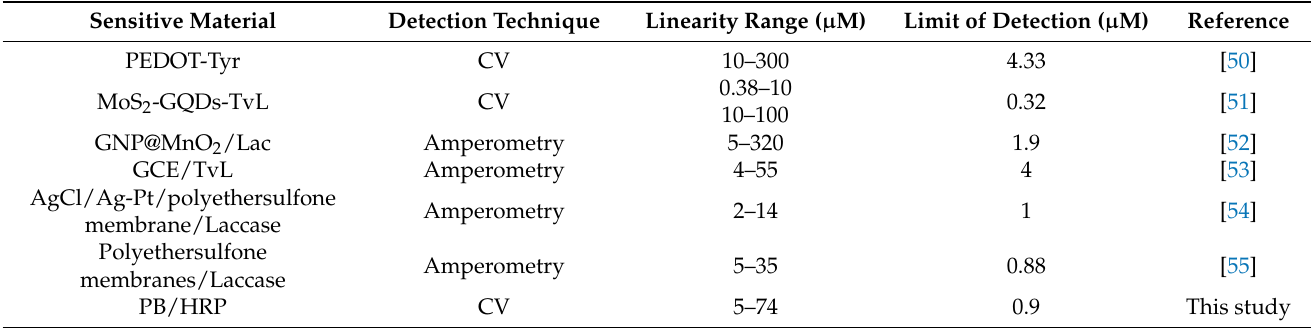
Figure 6. ( a ) Overlapping cyclic voltammograms of SPCE/PB/HRP biosensor, immersed in different solutions with variable concentrations of caffeic acid (electrolyte support was 10 − 2 M PBS pH 7–10 − 2 M hydrogen peroxide solution); ( b ) plot of linear calibration of the SPCE/PB/HRP biosensor for caffeic acid based on anodic peak currents; and ( c ) plot of linear calibration of the SPCE/PB/HRP biosensor for caffeic acid based on cathodic peak currents. Table 2. Enzymatic biosensors used to detect caffeic acid.